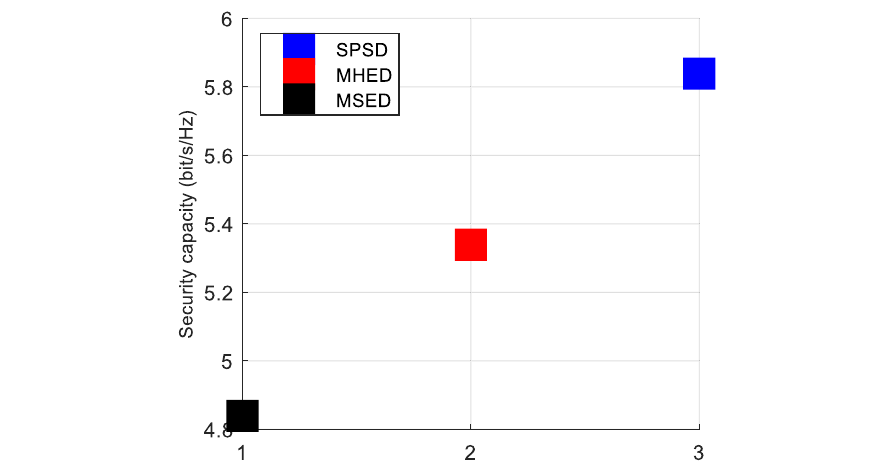
Fig. 7 The security capacity achieved by the three optimization schemes. The black block represents the security capacity achieved by MSED; the red block represents the security capacity achieved by MHED; the blue block represents the security capacity achieved by